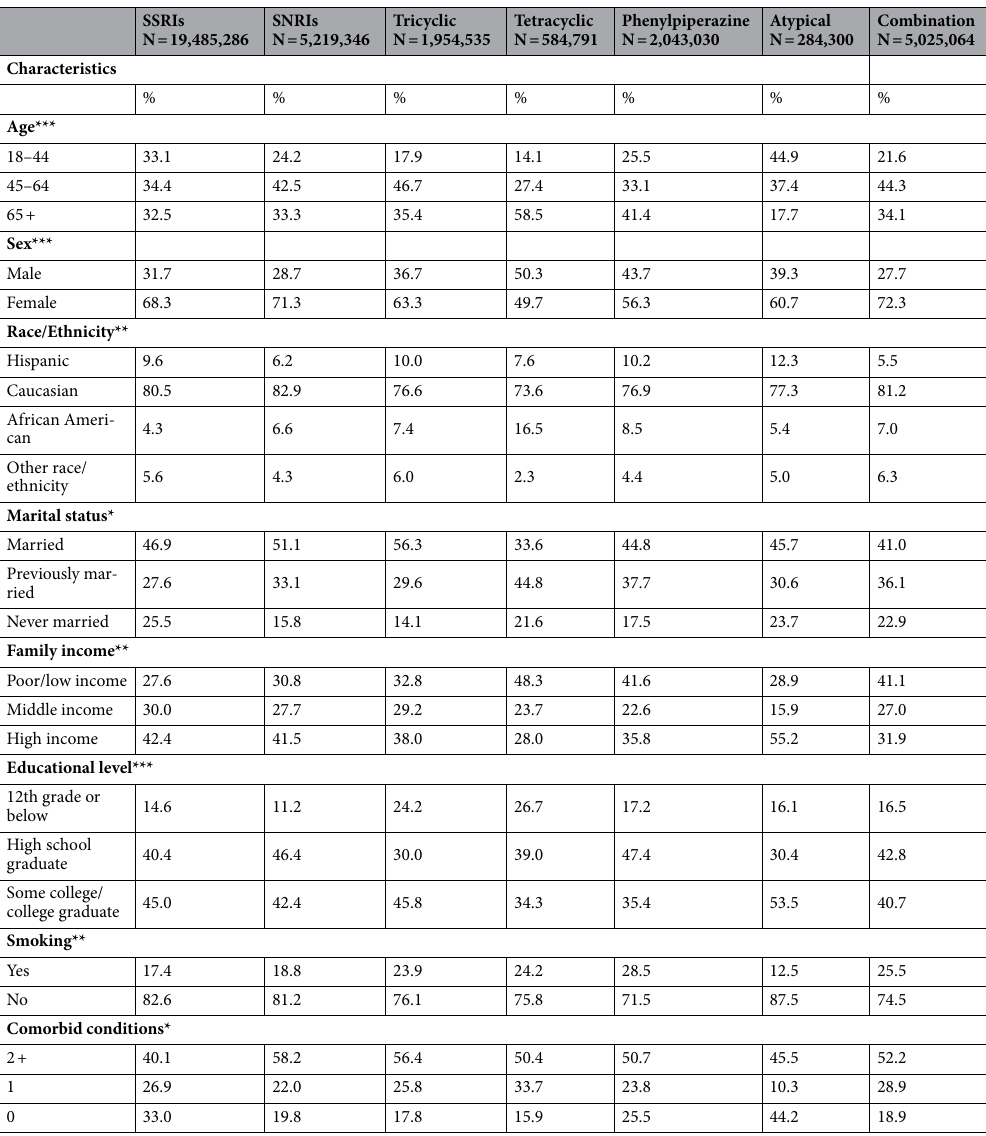
Table 1. Percentages of sociodemographic and clinical characteristics among antidepressant users. SSRIs: Selective serotonin reuptake inhibitors; SNRIs: Serotonin and norepinephrine reuptake inhibitors; Combination: Patients using multiple antidepressants. * p < 0.05; ** p < 0.01; *** p <